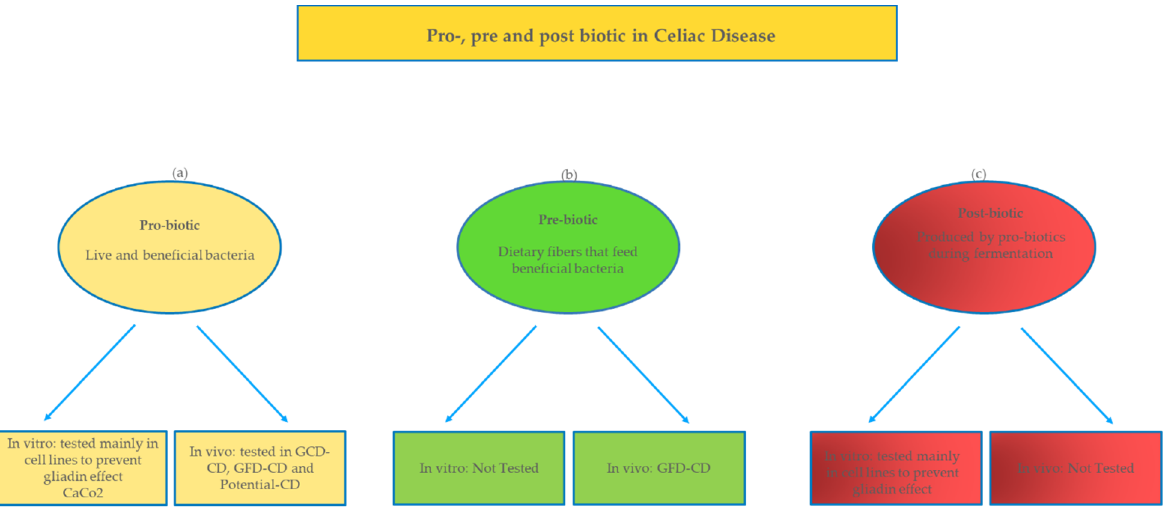
Figure 1. Schematic representation of the in vitro and in vivo experiments performed in CD with pro ( a ), pre ( b ) and post-biotics (c).